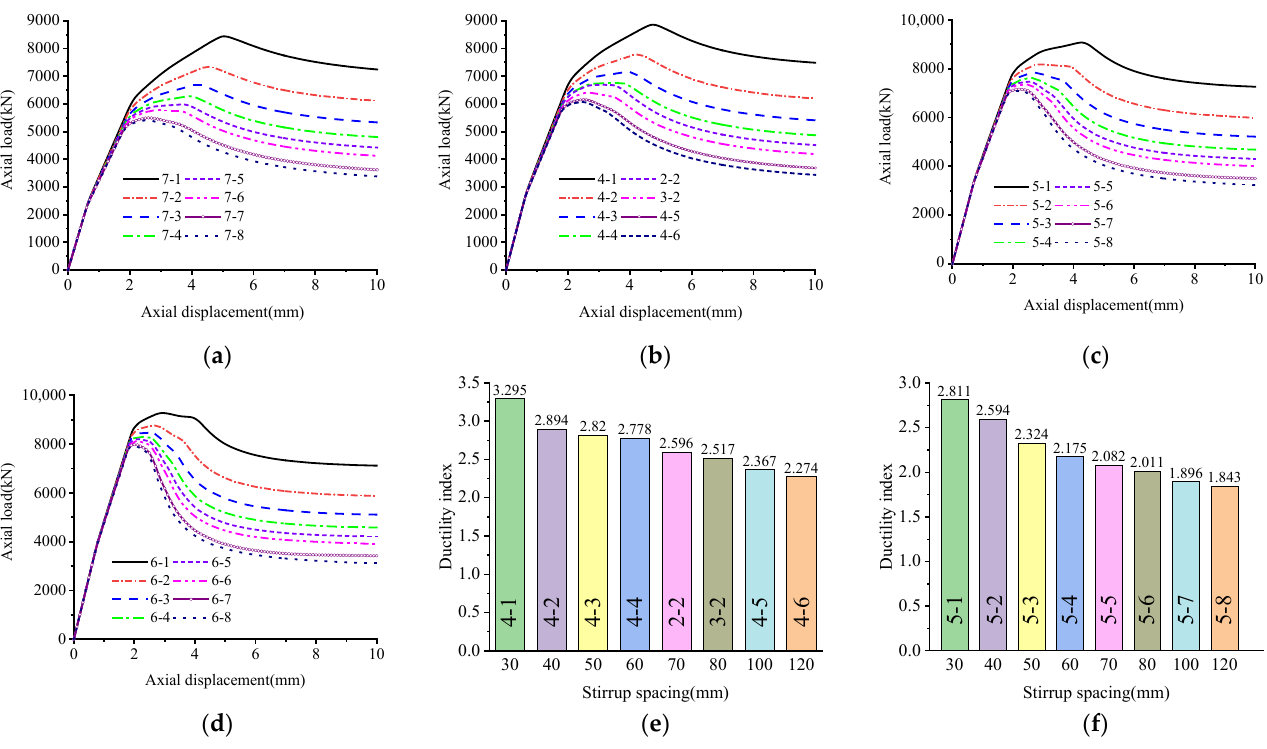
Figure 9. Effect of stirrup spacing: ( a ) f c = 26.8 MPa; ( b ) f c = 30.7 MPa; ( c ) f c = 38.5 MPa; ( d ) f c = 44.5 MPa; ( e ) ductility index ( f c = 30.7 MPa); ( f ) ductility index ( f c = 38.5 MPa).